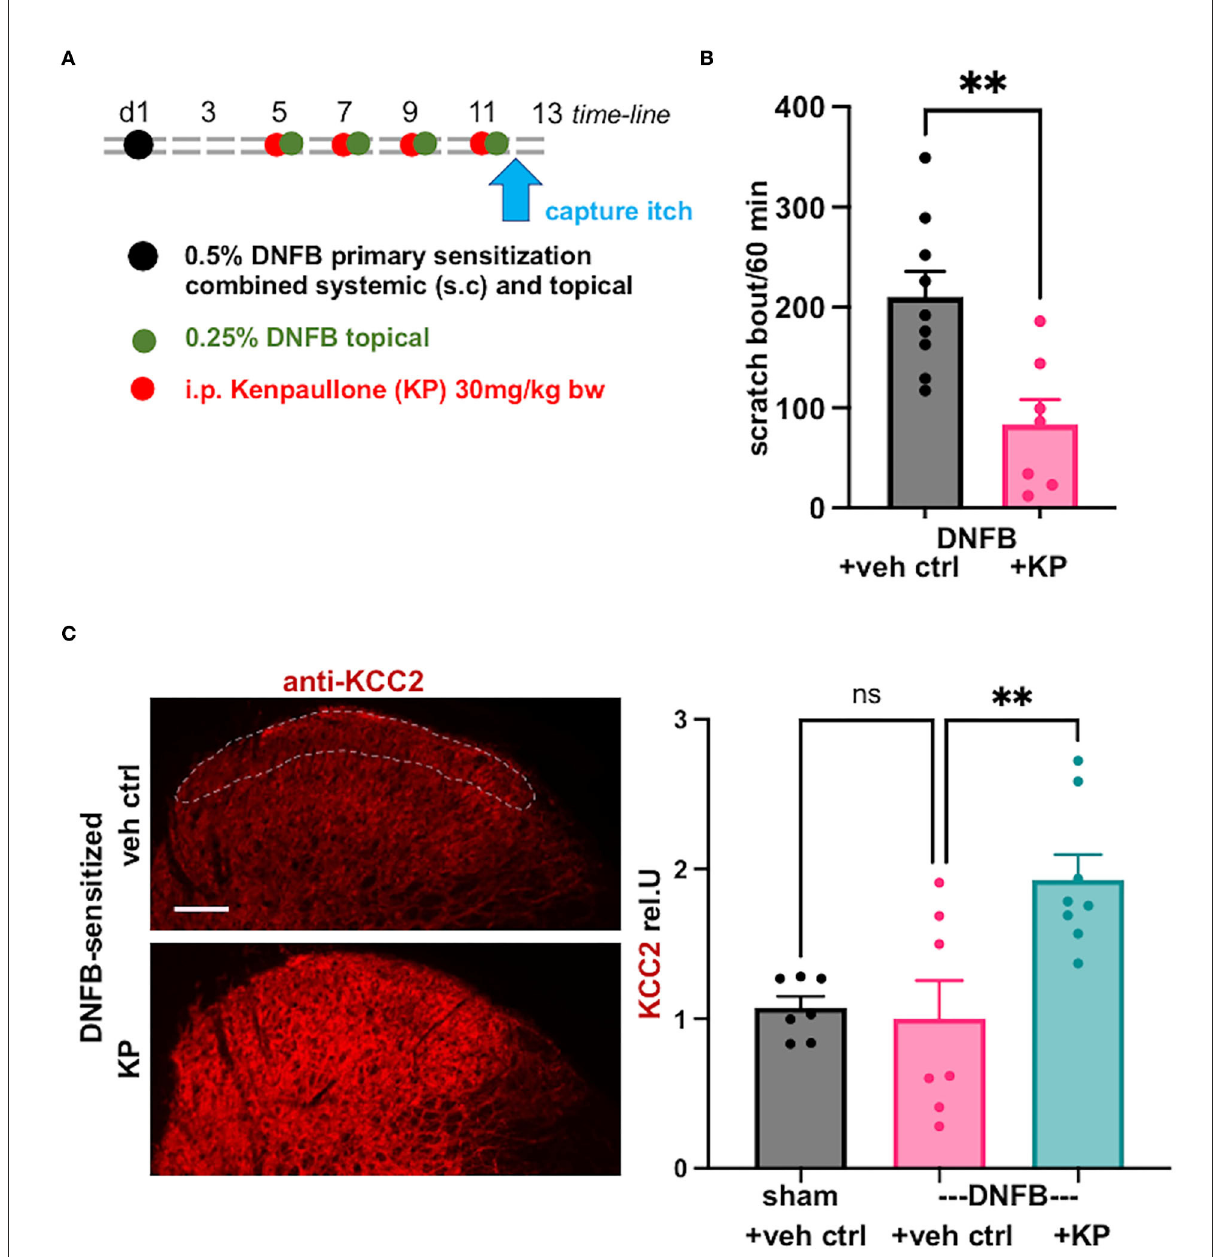
FIGURE4 Kcc2 gene-expression enhancing compound kenpaullone is effective in contact allergy-induced pruritus. (A) Shows a schematic overview of the experimental time-line, also see Methods. Videometric recording of scratching behavior as final read-out was conducted on d12. (B) This bar diagram shows robust scratching as a result of the DNFB contact sensitization (represented in black), and its significant attenuation by treatment with Kcc2 gene expression-enhancing compound, kenpaullone (kenpaullone; 30 mg/kg bw; represented in purple), note reduction by > 50%. Bars represent group mean + SEM, also individual animal datapoints; n = 9 mice for controls, n = 7 mice for kenpaullone; ** p < 0.01 t -test. (C) Kenpaullone treatment increases KCC2 expression in the SCDH in DNFB-sensitized mice. Left-hand micrographs: representative KCC2 immuno-staining of the SCDH of cervical segments that innervate the DNFB-treated pruritic area, region-of-interest for densitometric measurement of KCC2 in the SCDH outlined with dotted white line in upper micrograph, focus on Rexed layers I–II because of their relevance for neurotransmission of pruriceptive afferent signals. Scale bar in upper micrograph = 100 µ m, valid for both panels. Right-hand bar diagrams: kenpaullone [30 mg/kg; treatment protocol see (A)] increases KCC2 protein expression in SCDH vs. vehicle control in the DNFB contact allergy pruritus model. Data are represented as mean values ± SEM; n = 7-8 mice group; ** p = 0.0047, one-way